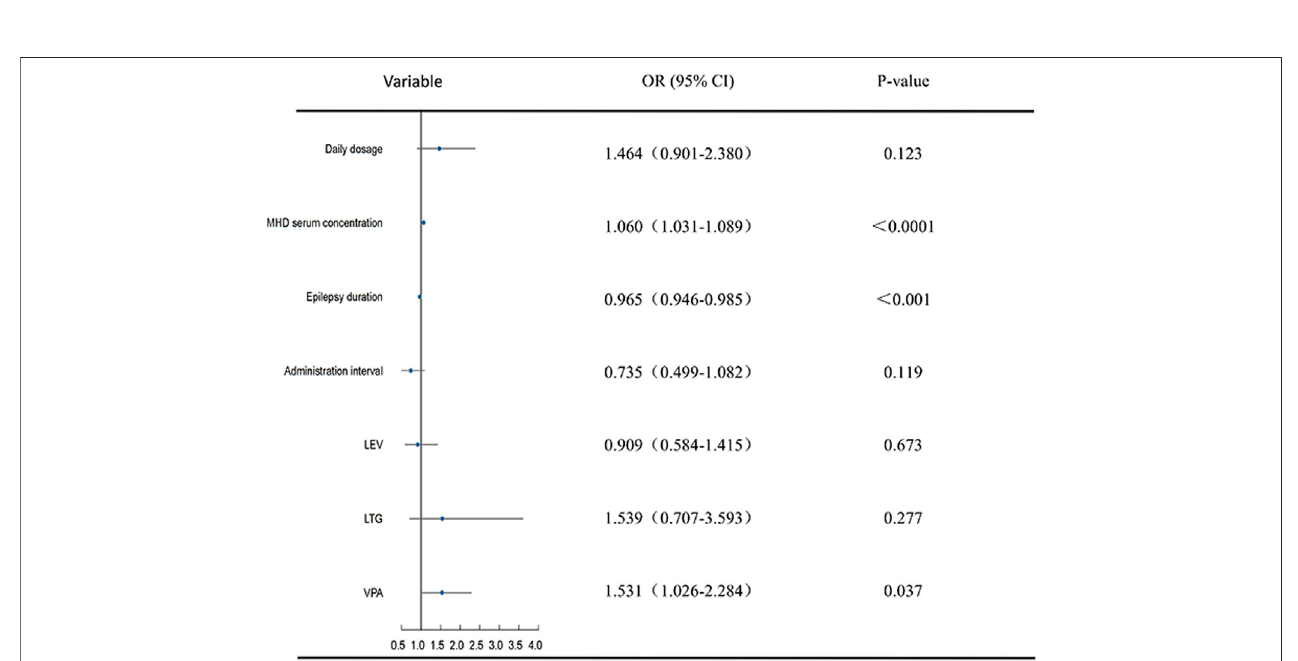
FIGURE 4 | Ordinal logistic regression analysis of predictors of OXC ef fi cacy.